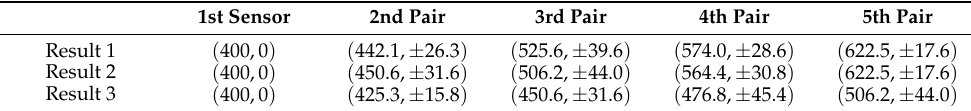
Figure 8. Sensor placement: the optimal placement; the uniform placement; the uniform placement in the head. Table 3. Coordinates of sensors’